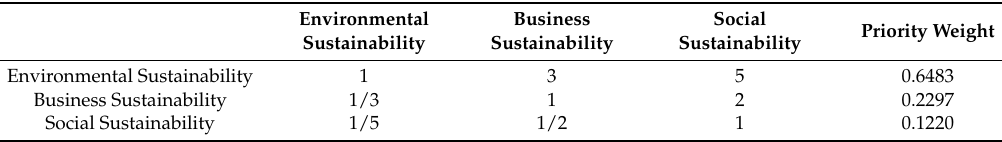
Table 3. Pairwise Comparison of the three main criteria w.r.t. Goal.